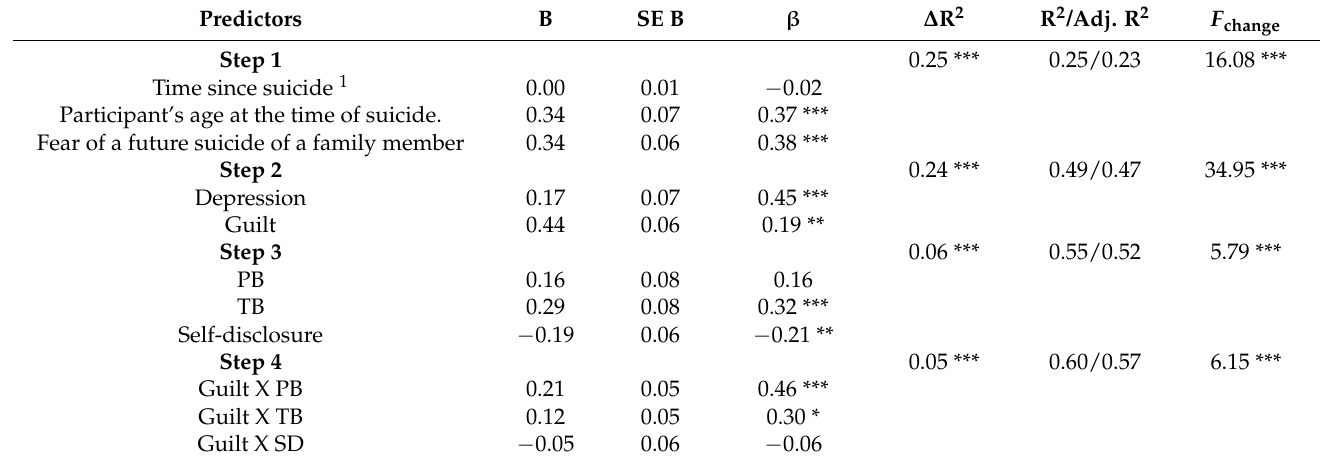
Table 2. Summary of hierarchical multiple regression analysis for predicting PGS ( n = 152).